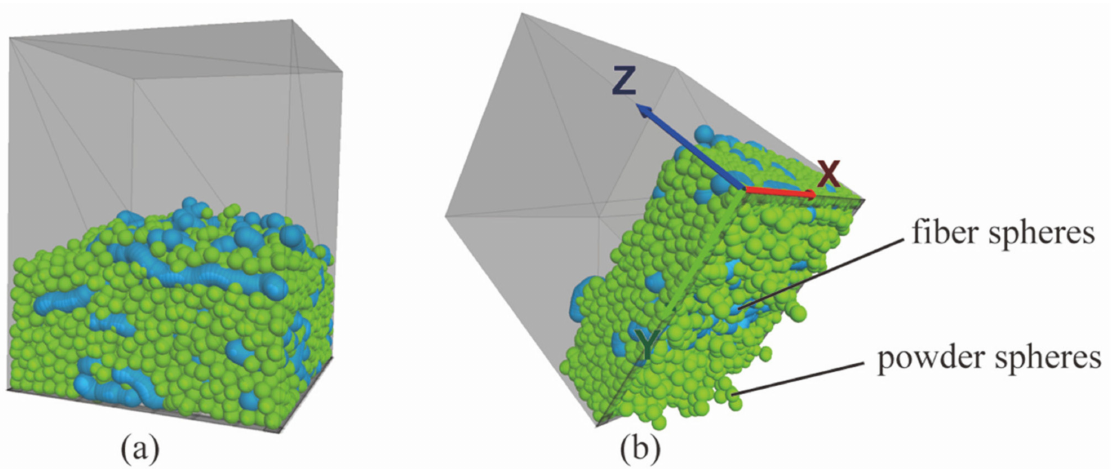
Figure 4. Snapshots of ( a ) the sealing grease arranged on the top of sieve evenly and tightly, and ( b ) the process of pressure resistant sealing test.